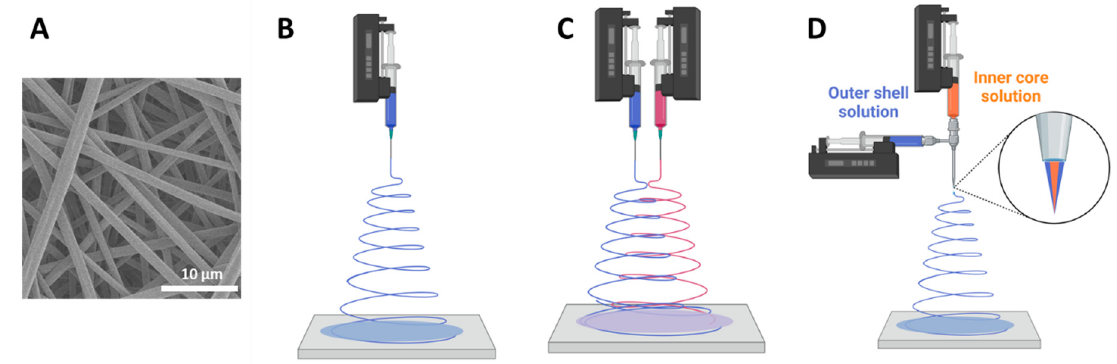
Figure 5. SEM image of an electrospun scaffold ( A ) and a simple schematic of the process of electrospinning ( B ) along with the nozzle for multi ‐ axial ( C ) and co ‐ axial electrospinning ( D ).